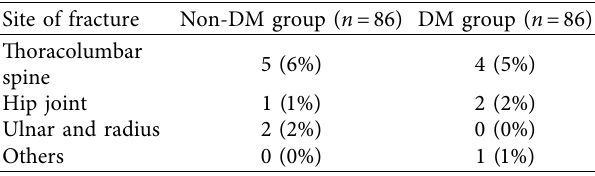
Table 4: Prevalence of fractures in postmenopausal women re- ceiving lumbar epidural